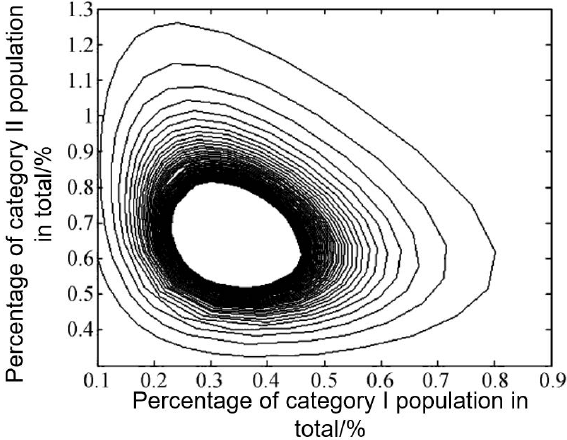
Fig. 4 Planar phase diagram of the number of people in category I and category